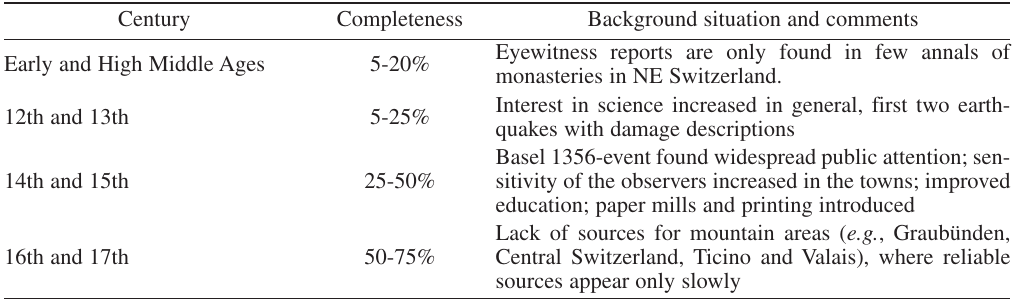
Table I. Estimated «completeness» of major earthquakes (Intensity ≥ VII) in the new ECOS 2002 catalogue from the historian’s point of